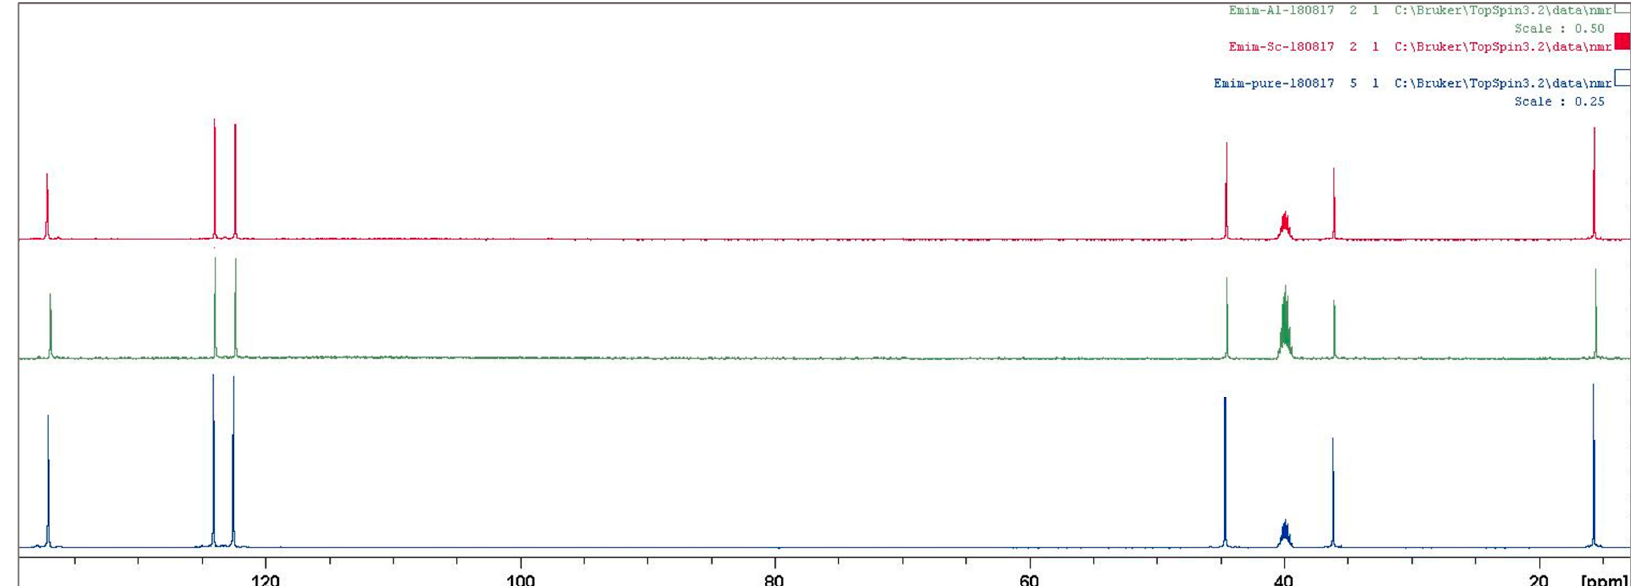
Figure A2. 13 C NMR comparison between [Emim][HSO 4 ] (blue), [Emim][HSO 4 ] after leaching Al 2 O 3 (green), [Emim][HSO 4 ] after leaching Sc 2 O 3 (red).